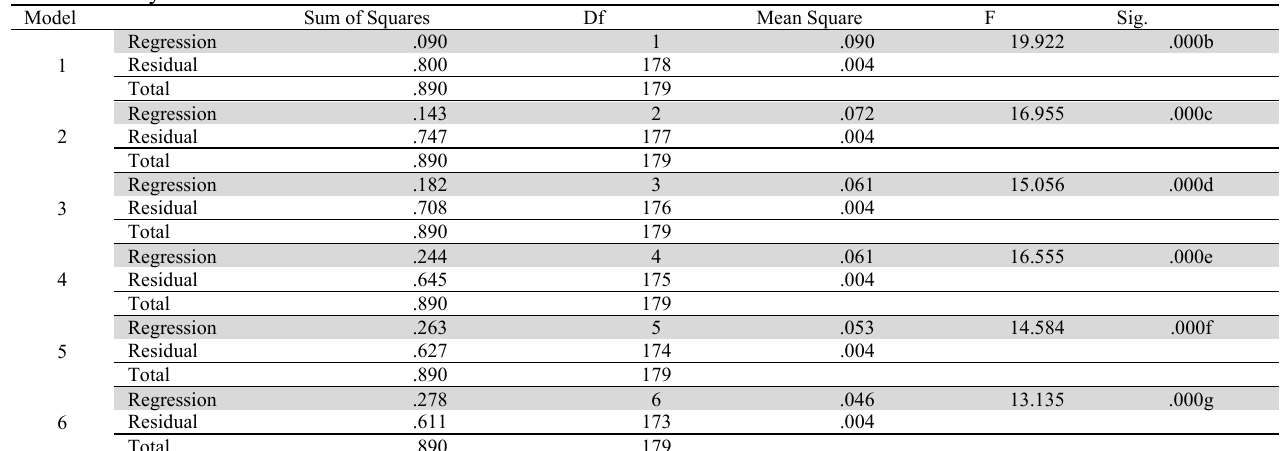
According to the analysis results, the model with the largest adjusted R square is 0.289, showing that the above independent variables explained 28.9% for the dependent variable of the information disclosure index. ANOVA analysis